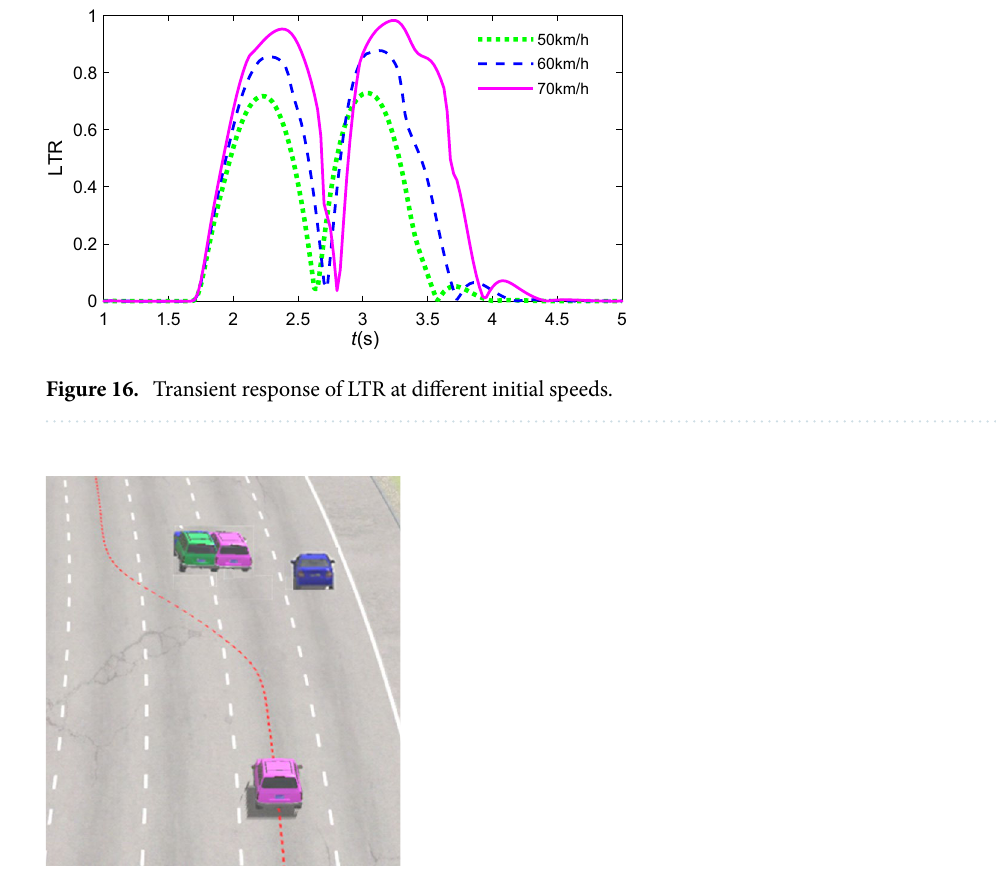
Figure 17. Dynamic visualization in highway emergency collision